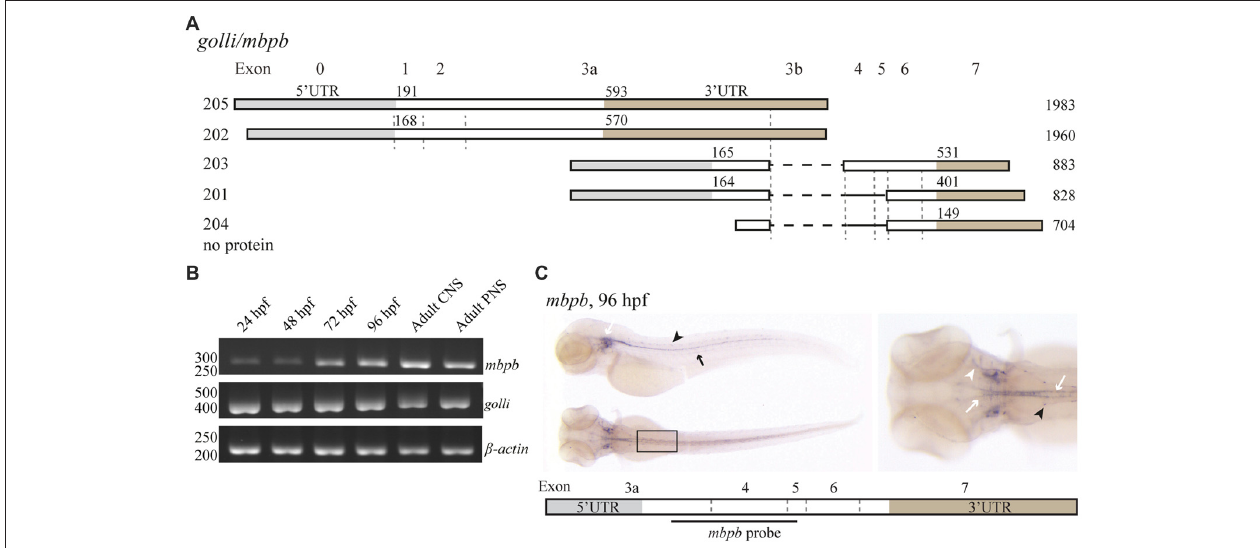
FIGURE 2 | mbpb expression is similar, but not identical to mbpa expression. (A) Schematic representation of the isoforms reported in the Ensembl database (release 90) originating from two different transcription start sites in the golli/mbpb gene unit. The numbers to the left indicate the identity of the isoform, the numbers above each isoform indicate the position of the first nucleotide in the coding sequence and the 3’UTR, respectively, and the numbers to the right indicate the total reported length. Isoforms 205 and 202 encode the Golli protein, while the isoforms 203 and 201 encode Mbpb. (B) RNA was purified from zebrafish larvae at the indicated hours post fertilization, and from the adult brain (CNS) or lateral line (PNS). RT-PCR was performed with equal amounts of RNA as template with primers recognizing either mbpb or golli mRNA. A primer set for β -actin was included as a control. (C) WISH performed on zebrafish larvae at 96 hpf with a probe specific for mbpb mRNA resulted in a robust signal in the hindbrain and ventral spinal cord (white arrows), and posterior (black arrow) and anterior (white arrowhead) lateral line system. Furthermore, mbpb mRNA was detected in a symmetrical pattern in the dorsolateral spinal cord (black arrowheads). Note the presence of mbpb mRNA in the myelin sheaths covering the fine axons travelling laterally from the midline in the hindbrain, best visible in the dorsal view of the head region. Images are representative of two individual experiments with at least 15 larvae examined for each WISH probe in each